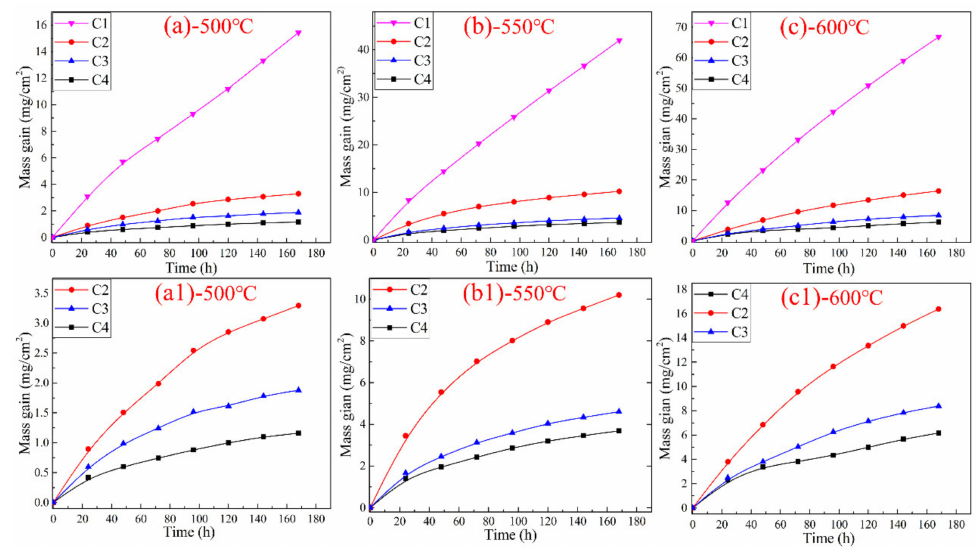
Figure 4. Mass gain of C1–C4 corroded in reducing atmosphere for 168 h at 500–600 ◦ C as a function of time: ( a ) 500, ( b ) 550, ( c ) 600, ( a1 ) 500, ( b1 ) 550, and ( c1 ) 600 ◦ C.